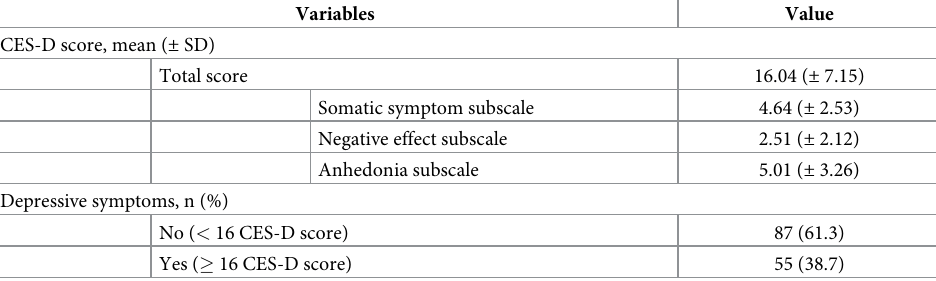
Table 3. Depressive symptoms in patients with